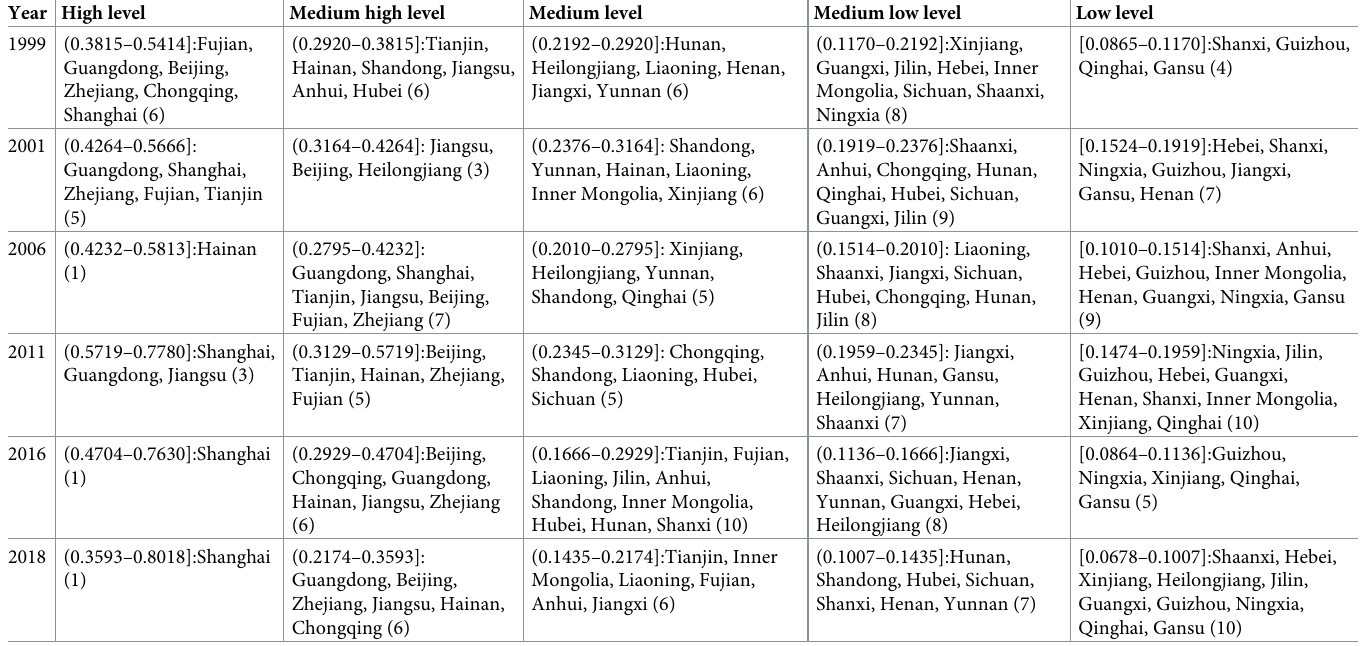
Table 4. Distribution of provinces in each high-quality development level